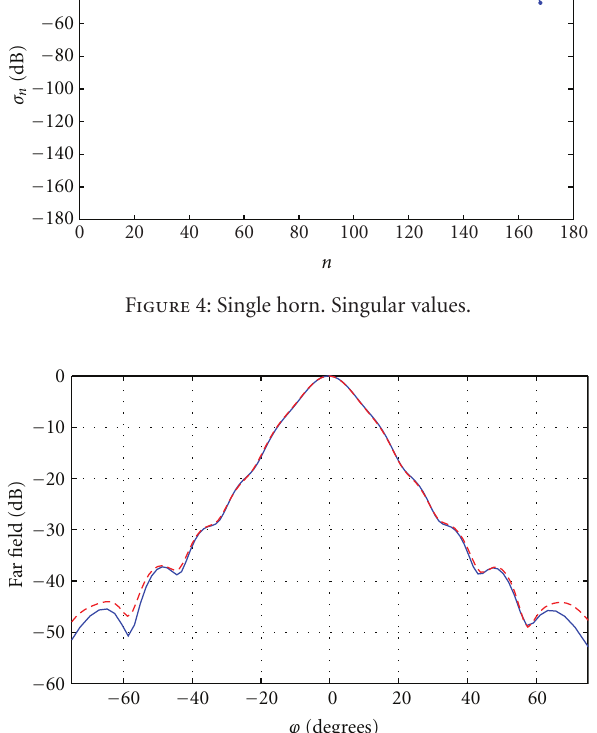
Figure 5: Single horn . ϕ cut of the ϑ component of the far field. Blue solid line: proposed approach. Red dashed line: approach in [6].